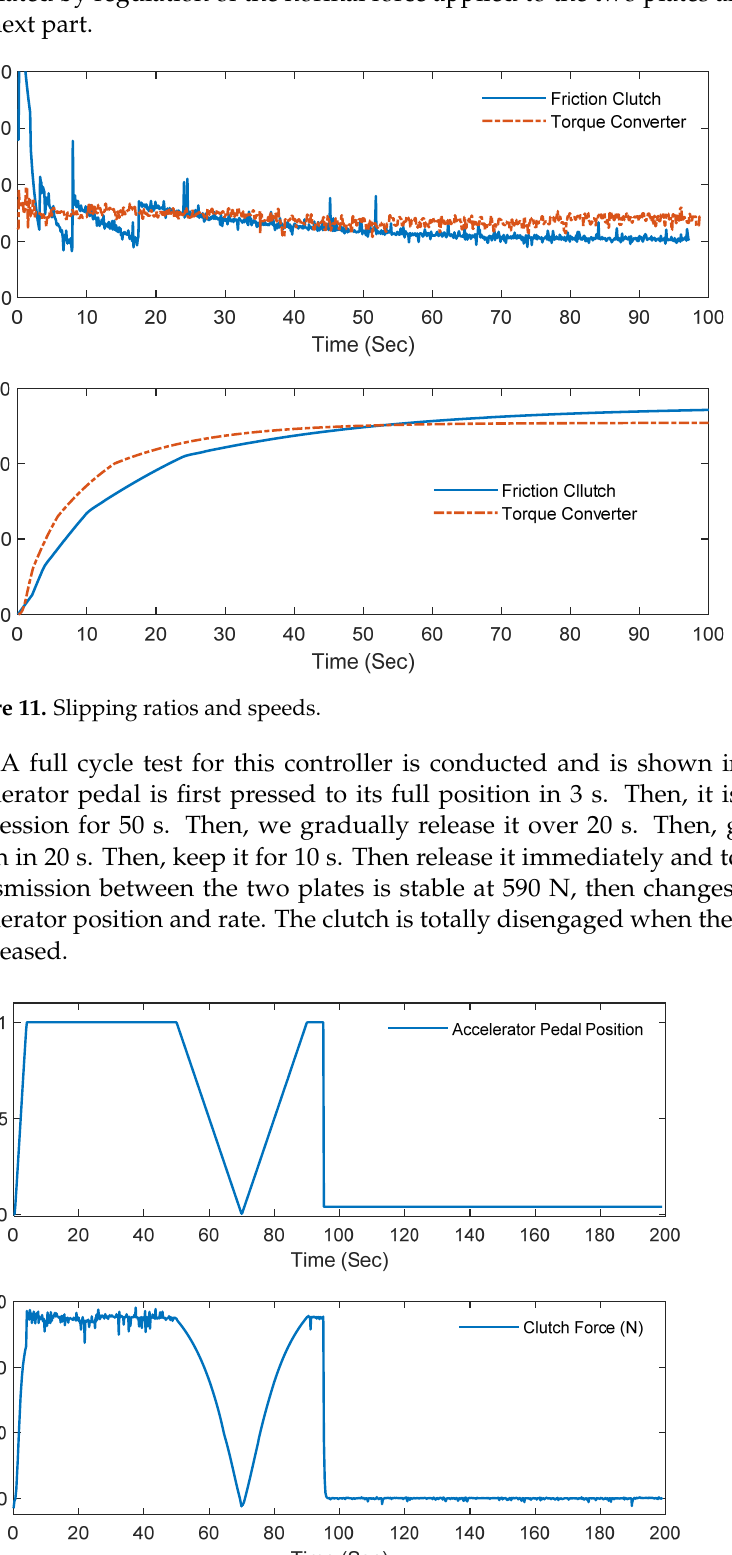
Figure 12. Automatic friction clutch performance.